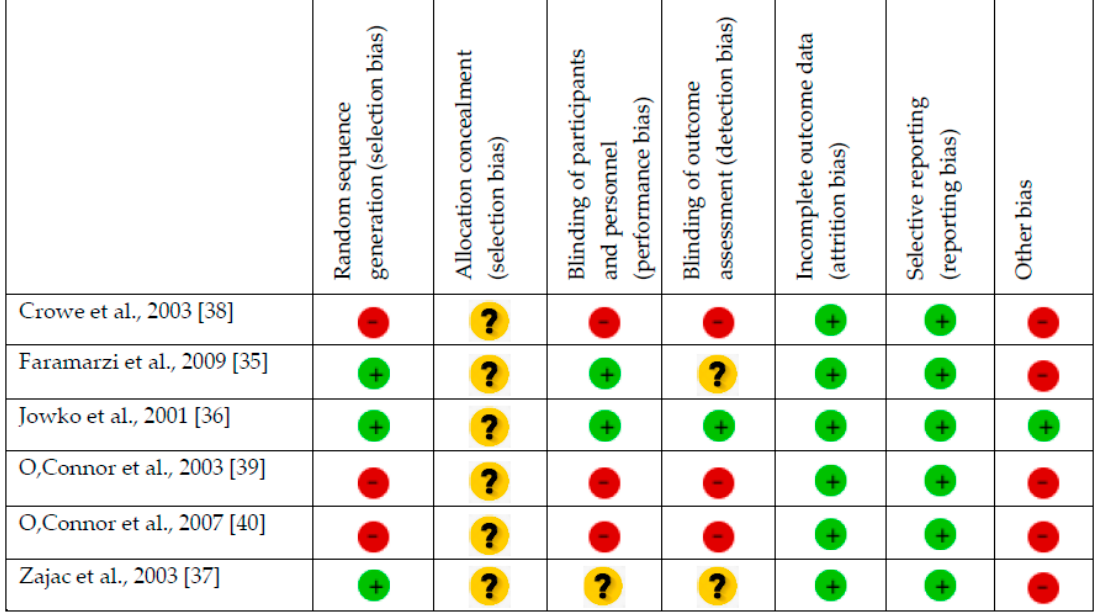
Figure 1. Risk of bias graph: review authors’ judgments about each risk of bias item presented as percentages across all studies. Indicates low risk of bias; indicates unknown risk of bias; indicates high risk of bias.